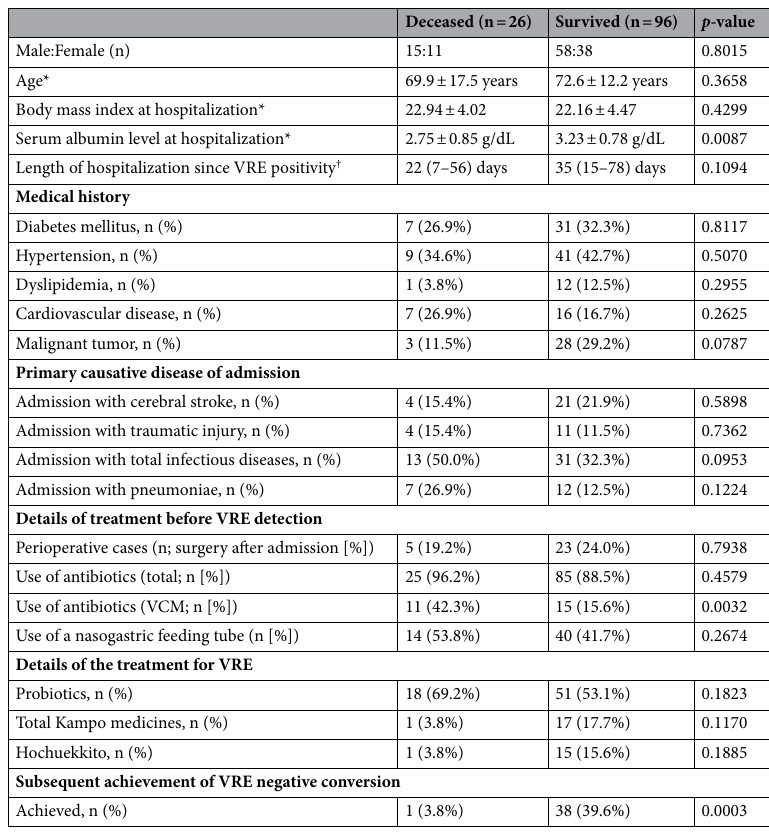
Table 1. Comparative analysis of clinical and therapeutic parameters according to subsequent mortality during hospitalization. Kampo medicines (total) means hochuekkito (n = 16), juzentaihoto (n = 1),